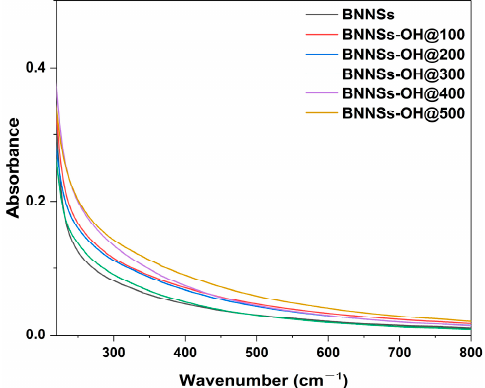
Figure 6. UV-vis spectra of the equilibrated aqueous solution of BNNSs and BNNSs-OH with different doses.